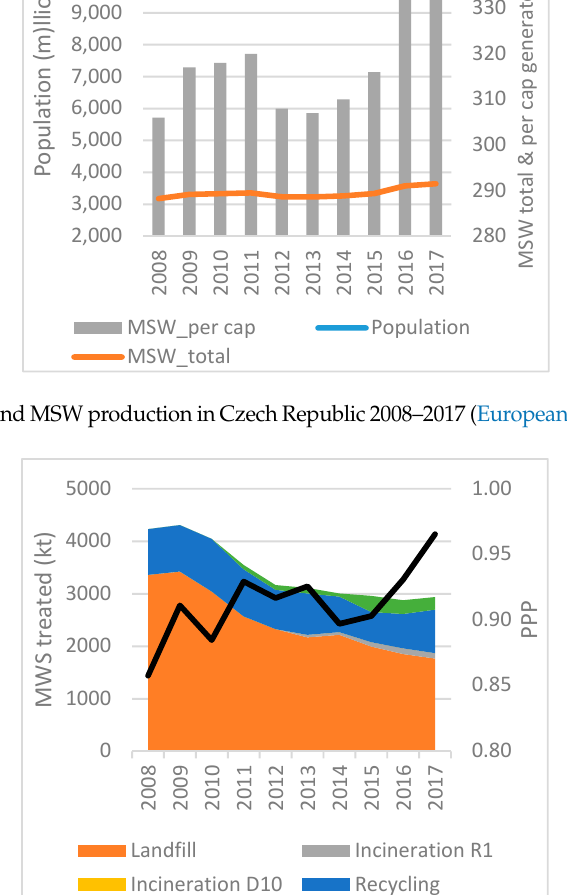
Figure 6. Waste treatment methods and PPP in Czech Republic 2008–2017 (EUROSTAT 2019b, 2019c).